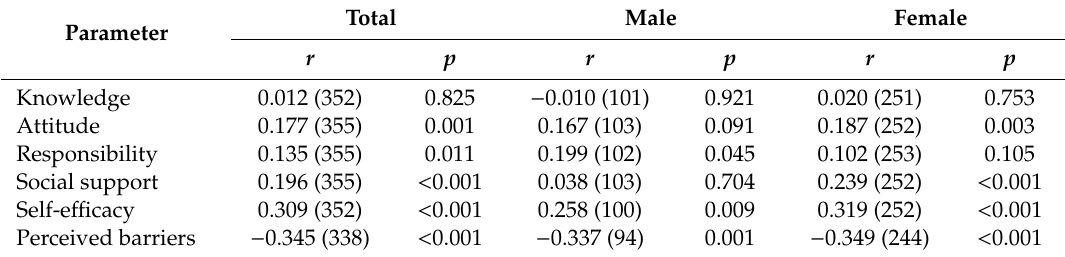
Table 7. Correlation between daily fruit consumption and psychosocial